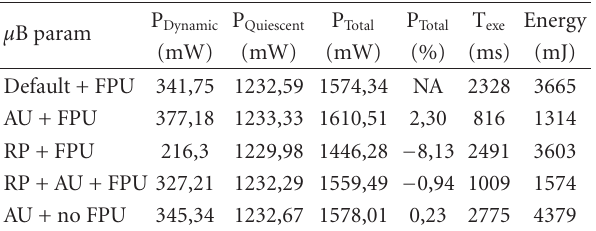
Figure 30: Impact of the MicroBlaze configurations for the ANN algorithm. Table 12: Impact of the MicroBlaze configurations for the ANN algorithm at 100 MHz for V5LX110T.